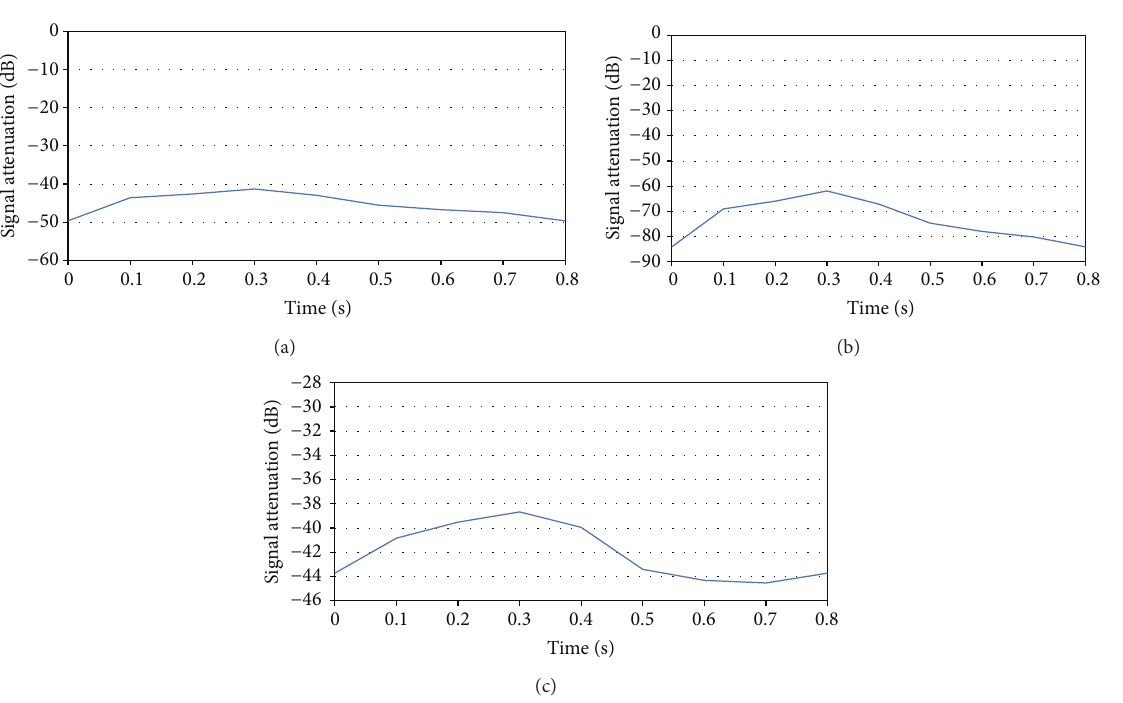
Figure 7: Variation of signal attenuation with time at (a) 0.1 GHz, (b) 0.5 GHz, and (c) 1GHz,